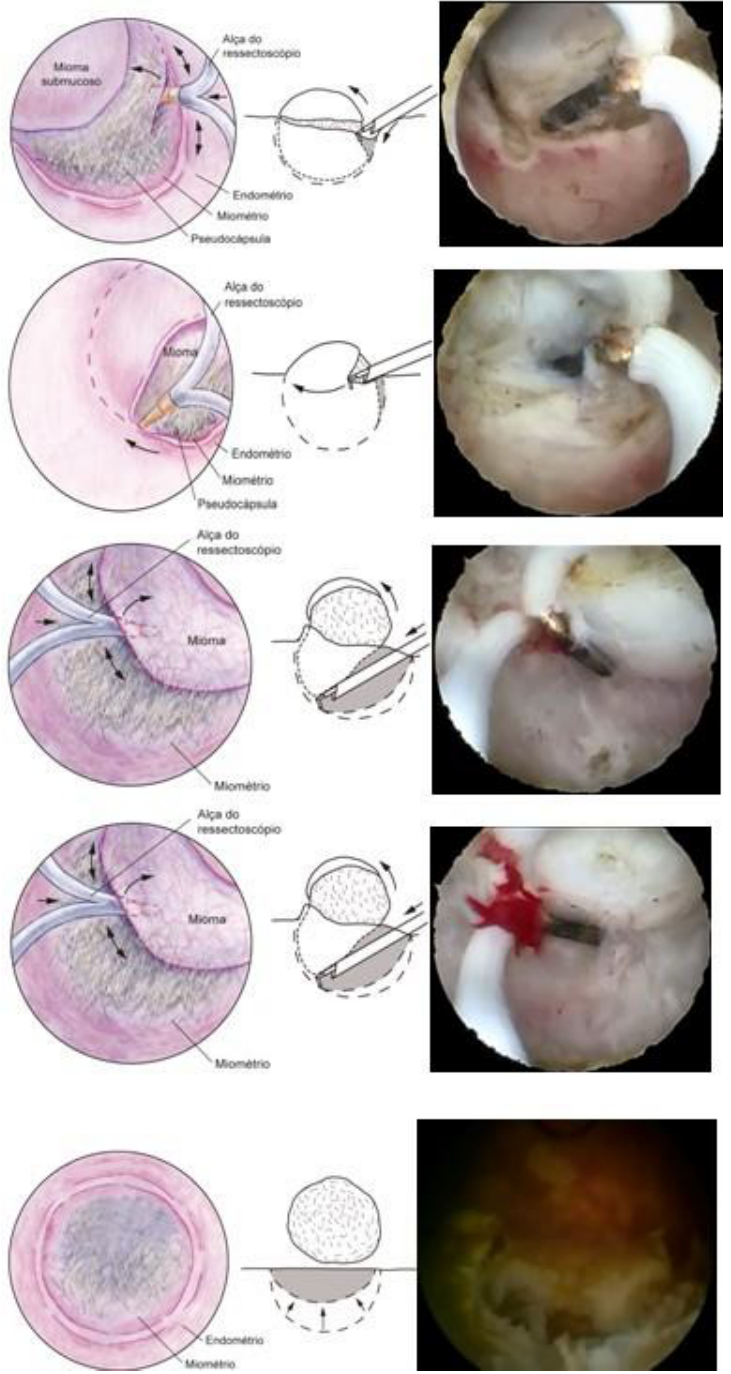
Figure 14. OR hysteroscopic myomectomy, with Collins electrode, enucleation, and preserving pseudocapsule.